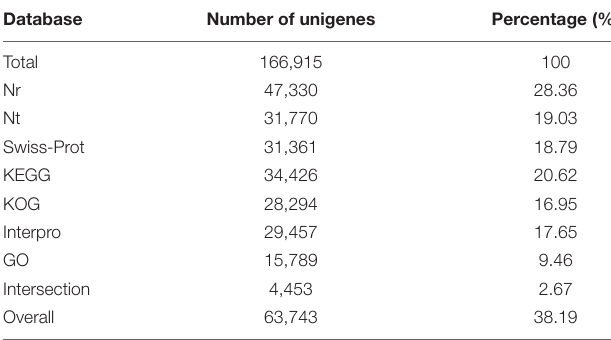
TABLE 2 | Statistical summary of the annotated